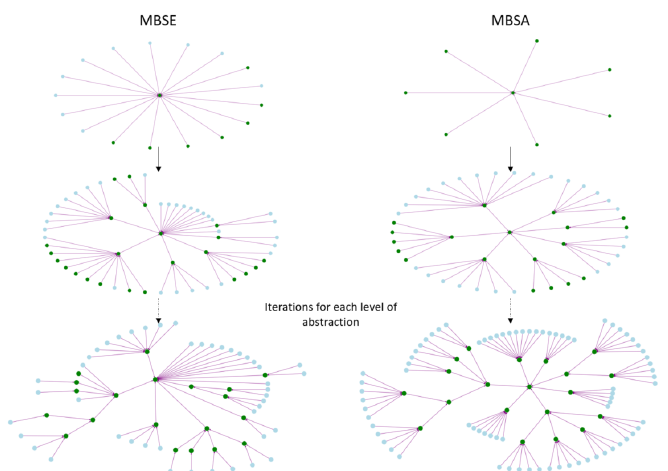
Figure 16. Diagrams for the S2ML models of the fixed-wing drone during iterations of SmartSync over the architecture and safety models.